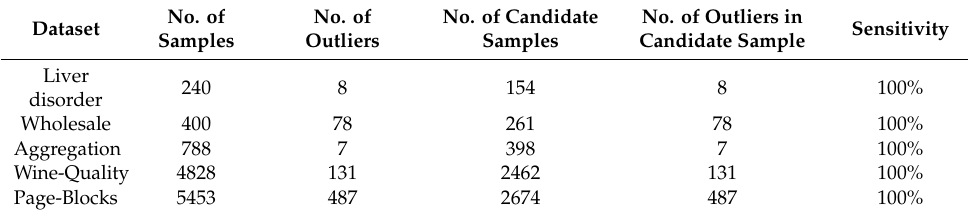
Table 4. The summary of 5 real-world datasets after dataset